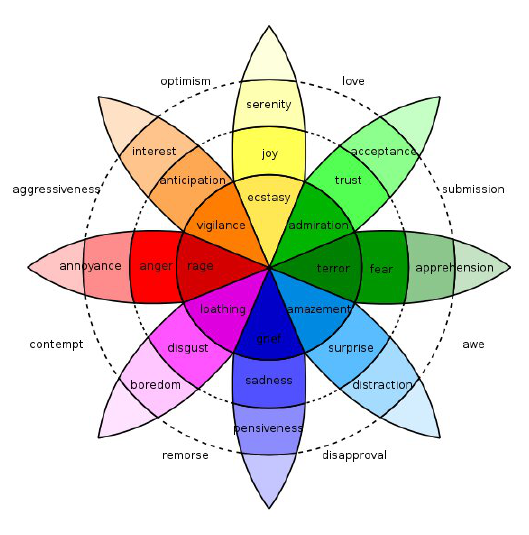
Figure 2. Emotion wheel (Source: